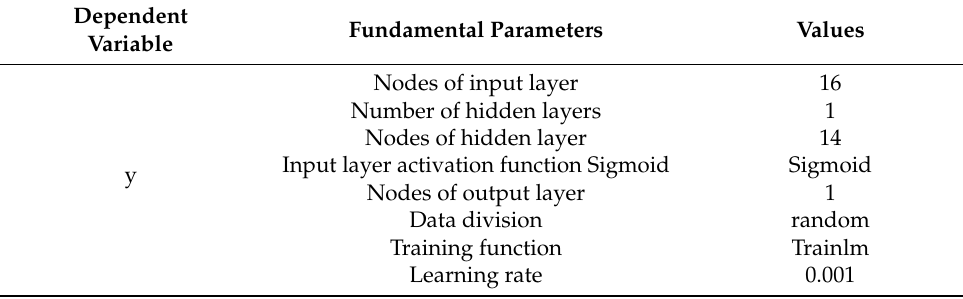
Table 5. Fundamental parameters of BP neural